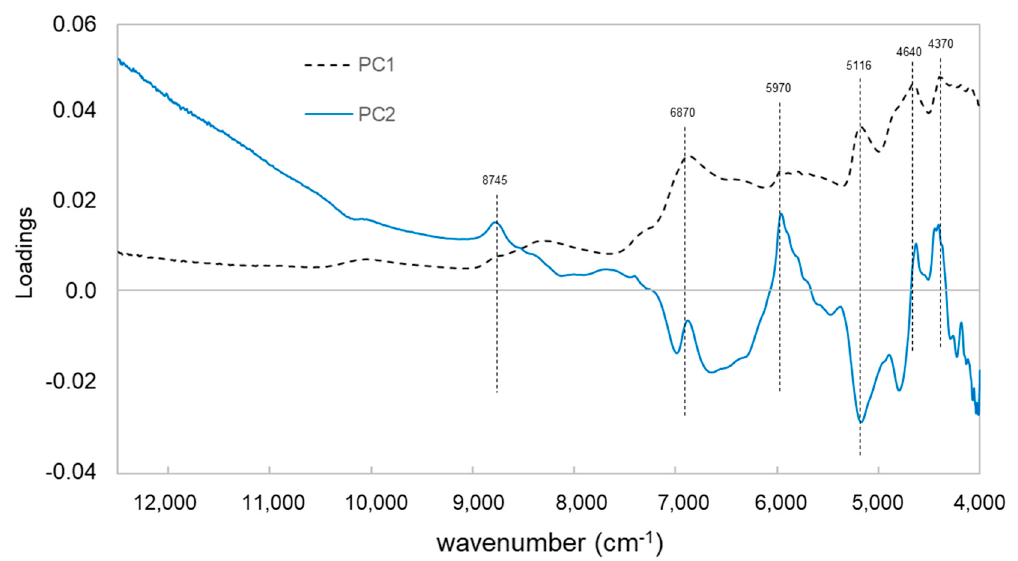
Figure 8. Loadings of the first two principal components (PCs) of near infrared spectra of various wood types.